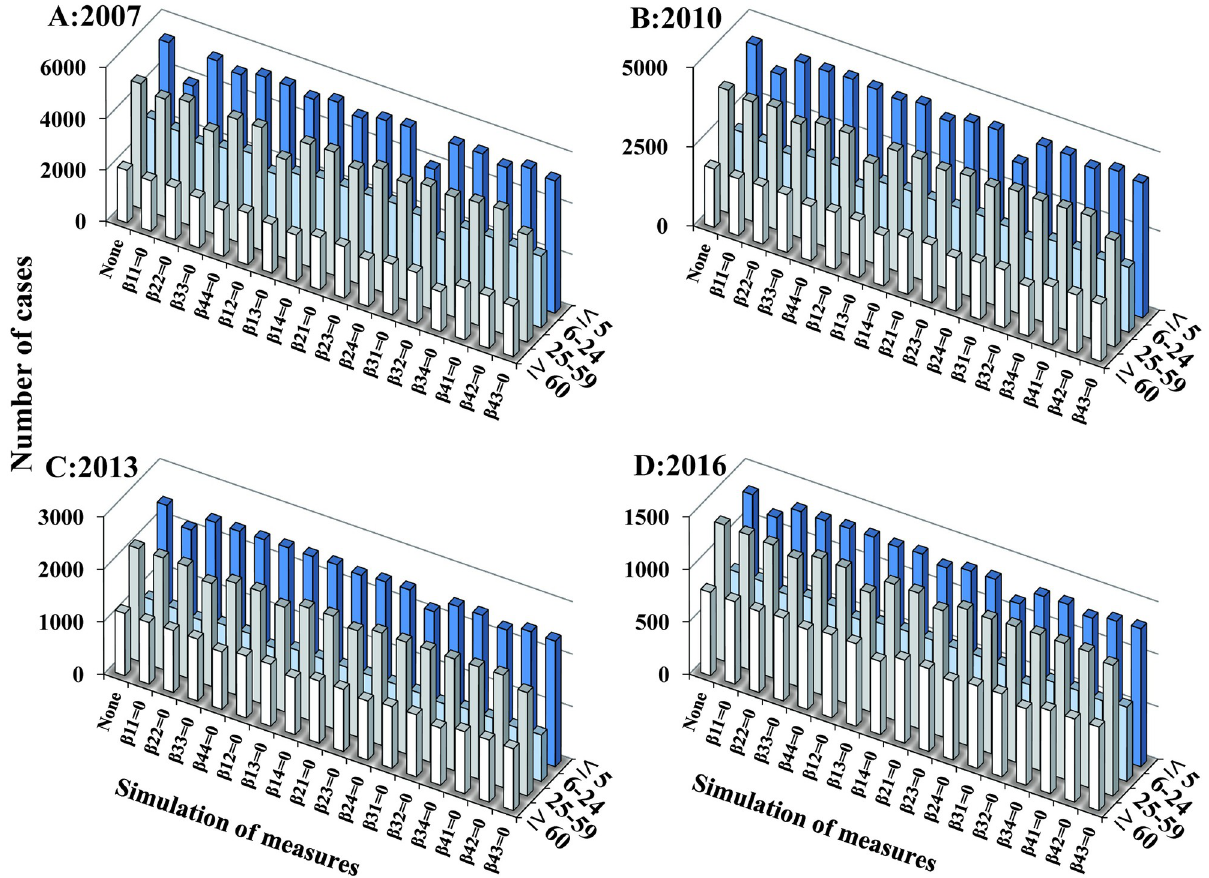
Fig 8. The “knock-out” simulation of scenarios I during the transmission in 4 stages. The bar shows the number of cases calculated without any intervention (control) or when cutting off just one transmission route ( β ij = 0, i and j respectively equal to 1, 2, 3 and 4). A) 2007. B) 2010. C) 2013. D)